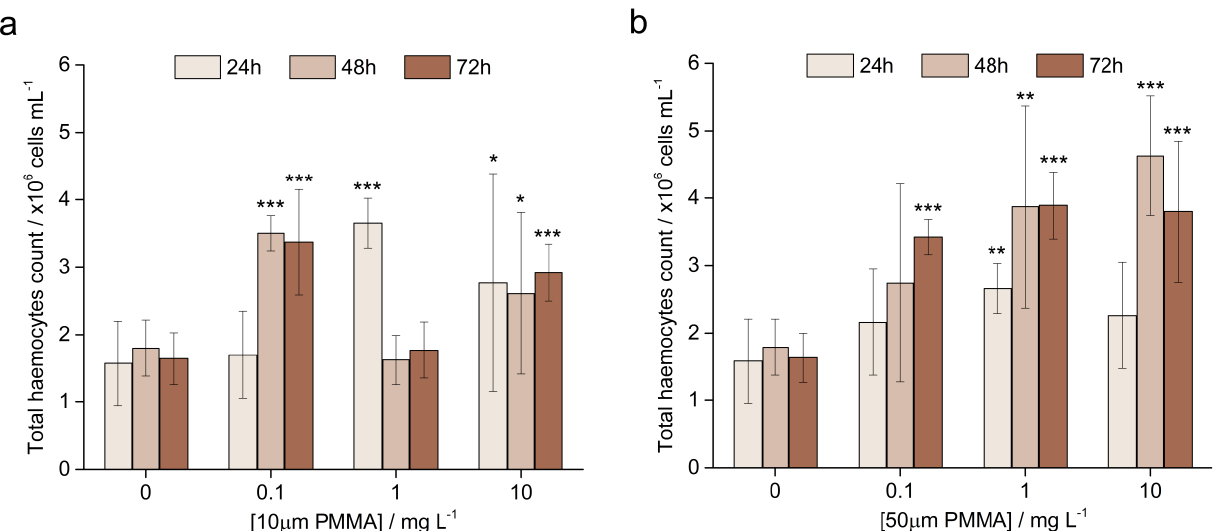
Figure 3. The THC (mean ± SD) after 24, 48, and 72 h for control mussels (CON) and mussels exposed to 0.1 mg L − 1 (LOW), 1.0 mg L − 1 (MID), and 10 mg L − 1 (HIGH) PMMA microparticles of ( a ) 10 µ m diameter and ( b ) 50 µ m diameter. Statistical significance is indicated at the levels * p < 0.05, ** p < 0.01, *** p <